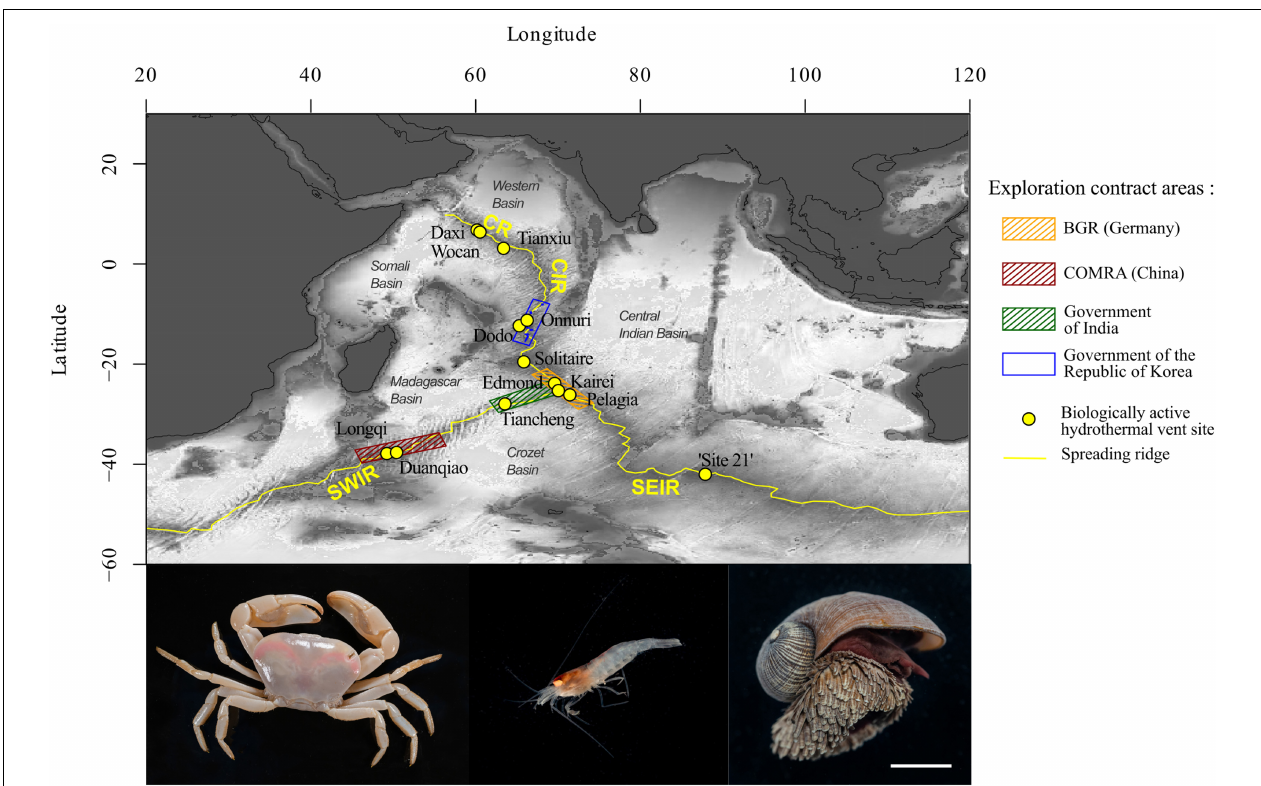
FIGURE 1 | Biologically active hydrothermal vents of the Indian mid-ocean ridges. The Indian Ocean counts eight topological ridges, including four that are active plate boundary rift zones. In recent years, exploration campaigns by the Federal Institute for Geosciences and Natural Resources of Germany (BGR), COMRA (China), the Government of India, and the Government of the Republic of Korea (6 areas within the blue rectangle), who were awarded exploration permits by the ISA between 2011 and 2016 (Minerals: Polymetallic Sulfides | International Seabed Authority), resulted in the discovery of additional vent fields on the CIR, CR, SWIR, and SEIR. At the time of writing this review, 13 active hydrothermal vent fields with associated macrofaunal communities have been described in the Indian mid-ocean ridge. Some of the endemic taxa of the Indian ridges are shown. Bottom-left: Austinograea rodriguezensis, bottom-middle: Mirocaris indica, bottom-right: Chrysomallon squamiferum . Scale bar = 2 cm. Bathymetric data from NOAA, exploration contract areas from https://www.isa.org.jm/exploration-contracts/polymetallic-sulfides. Photos courtesy of Dr. Jin